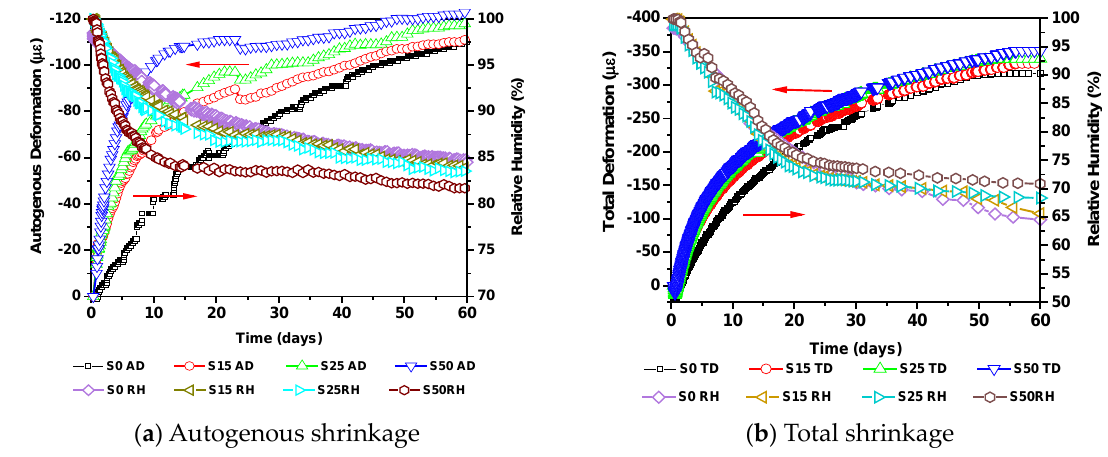
Figure 9. Deformation of slag concrete after stream curing.